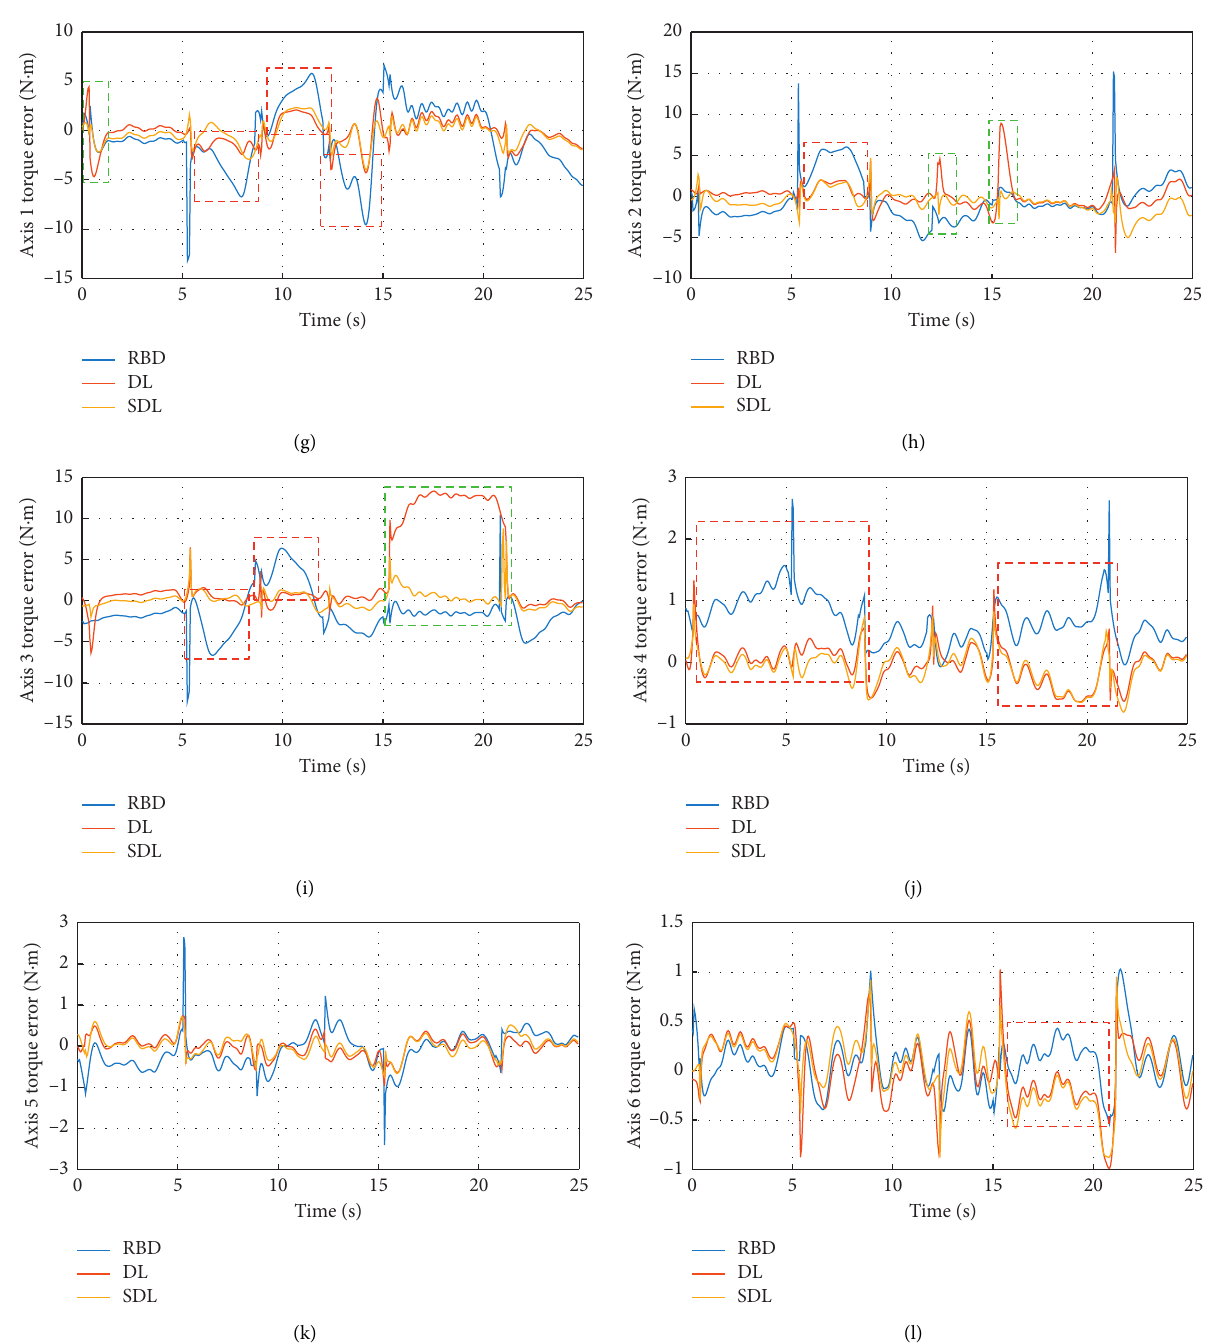
Figure 7: Joint torque prediction comparison curves. (a) Axis 1 torque. (g) Axis 1 torque error. (b) Axis 2 torque. (h) Axis 2 torque error. (c) Axis 3 torque. (i) Axis 3 torque error. (d) Axis 4 torque. (j) Axis 4 torque error. (e) Axis 5 torque. (k) Axis 5 torque error. (f) Axis 6 torque. (l) Axis 6 torque